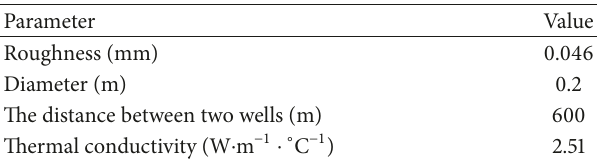
Table 1: Geological and thermophysical conditions of the reservoir. Table 2: Specification for